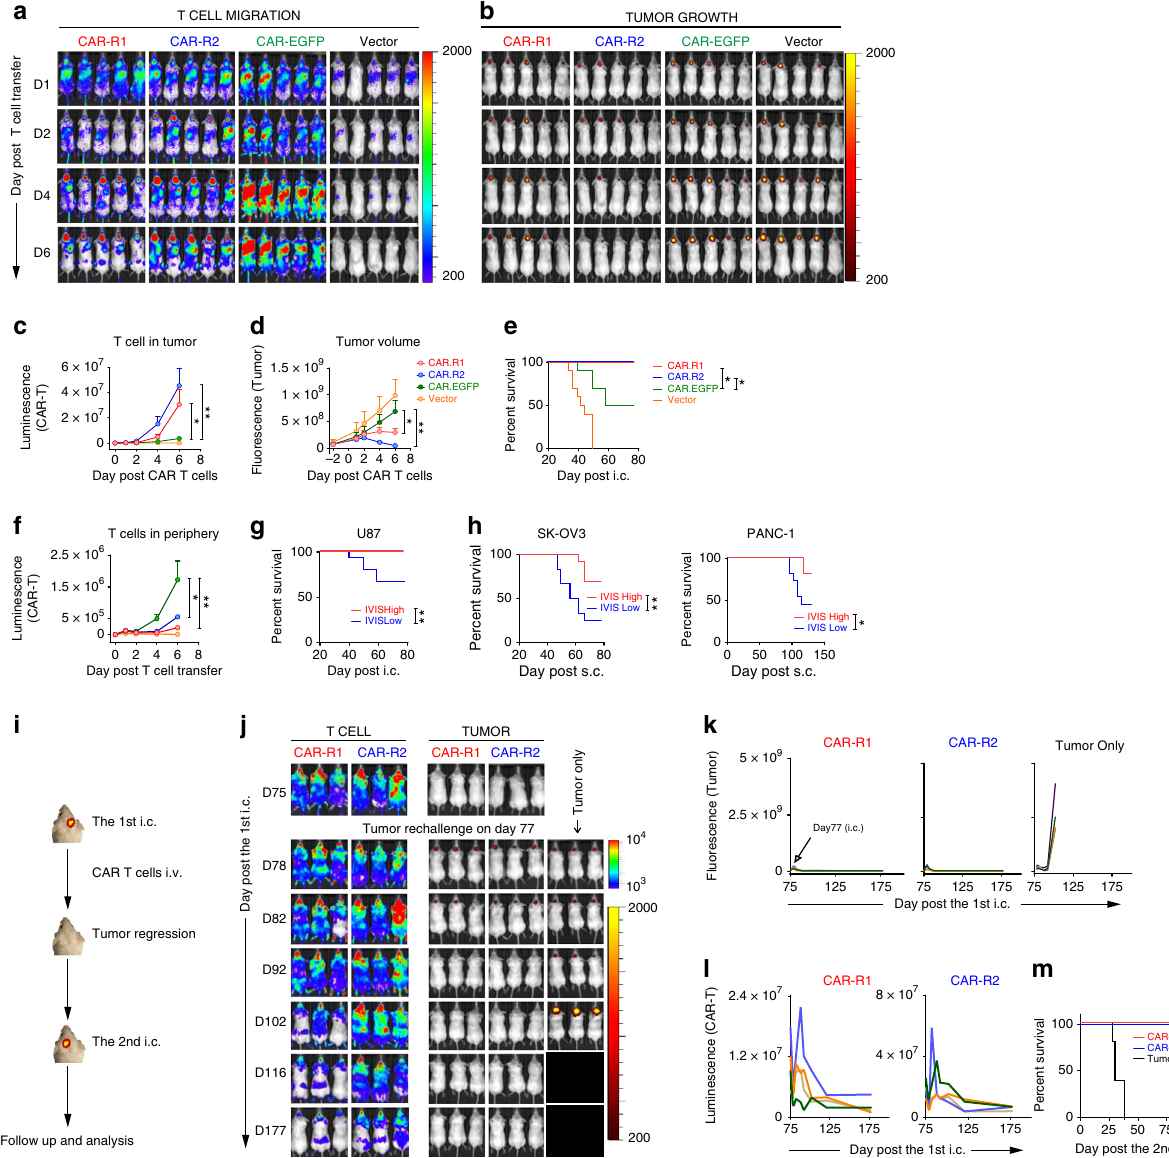
Fig. 6 8R70CAR T cells cure late-stage tumors and provide long-term protection. a , b The 8R70CARs and un-mod-70CAR T cells in treating a late-stage tumor model. Compared with the experiment in Fig. 3a, the local radiation was delayed until day 22 and day 23, followed by CAR T-cell injection i.v. on day 29. Images show CAR T-cell tumor traf fi cking and tumor growth after adoptive transfer. c , d Kinetics of T-cell tumor traf fi cking and tumor growth at ROI. Data represent means ± SEM. e Survival of CAR-R1, CAR-R2, CAR-EGFP, and vector-treated mice. Kaplan – Meier survival curves are displayed. f Quantitation of T-cell signals in the periphery using the data shown in ( a ). g The correlation between early IVIS imaging signals post-treatment and survival in GBM. Mice of all three CAR T cell-treated groups described in ( a ) were strati fi ed into low and high groups based on the median value of luminescence signals by IVIS, 1 day post-treatment. The survival difference between the groups was determined by Kaplan – Meier survival analysis. h Con fi rmative analysis of the correlation between early T-cell signals (3 days post-treatment) and survival using the results of the ovarian and pancreatic tumor models described in Fig. 3i, k, n, and p. i Experimental schema of tumor rechallenge. j Representative images of cured mice and tumor rechallenge. The cured mice treated by the CAR-R1, CAR-R2 T cells were i.c. inoculated with fresh tumors on the contralateral site with 5 × 10 4 /mouse U87.i720 on day 77 after fi rst tumor implantation. Tumor-only controls represent naïve mice with the same tumor implantation. k , l Tumor growth and CAR T-cell tumor traf fi cking following tumor rechallenge. Each line represents a single mouse. m Kaplan – Meier survival curves of the rechallenged mice (four mice/group). The Mann – Whitney U test was used, and the log-rank test was used for the survival analysis. * p < 0.05, ** p < Immunohistochemistry . Mouse brain tumor samples were immediately fi xed in 4% speci fi cally for IL-8 (Hs00174103_m1) gene expression with SsoAdvanced Uni- PFA or 0.2% formalin, and cryoprotected by 15% and then 30% sucrose solutions. versal Probes Supermix (Bio-Rad Laboratories) according to the manufacturer ’ s All samples were embedded in OCT, slowly frozen in a slush of dry ice and 100% protocols, and RPL13A (Hs01578912_m1) was used for normalization. qPCR runs alcohol, and then cryosectioned (5 or 10 μ m). Intratumoral IL-8 expression test was were performed on the QuantStudio ™ 12 K Flex Real-Time PCR System (Ther- carried out using IHC, performed by the Molecular Pathology Core at the University moFisher Scienti fi c) or CFX96 Touch ™ Real-Time PCR Detection System (Bio-Rad of Florida. Brie fl y, the Dual Endogenous Enzyme (Agilent) was used to quench Laboratories). Relative quanti fi cation of gene expression was carried out via the endogenous peroxidase activity. To reduce nonspeci fi c background staining, 2.5% delta Ct methodology.